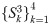
Euclidean distance of 3-dim clusters {Sk3}k=14.